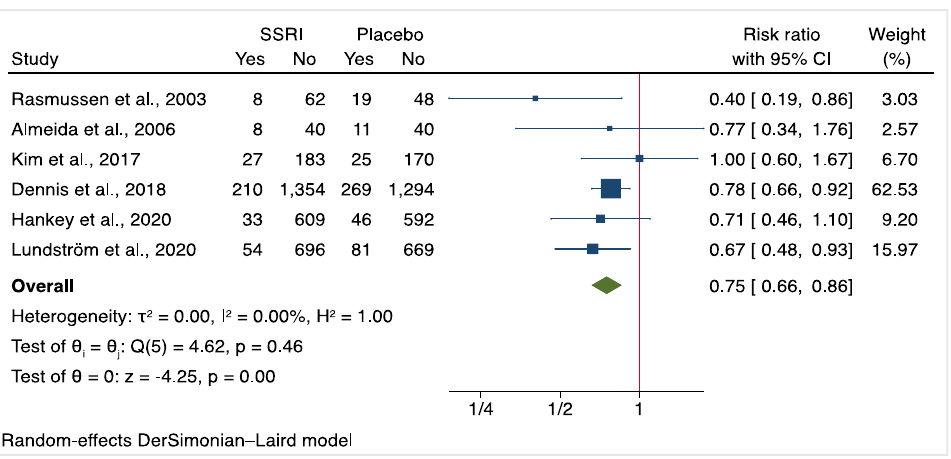
Figure 2. Forest plot of PSD occurrence comparing SSRI versus placebo.